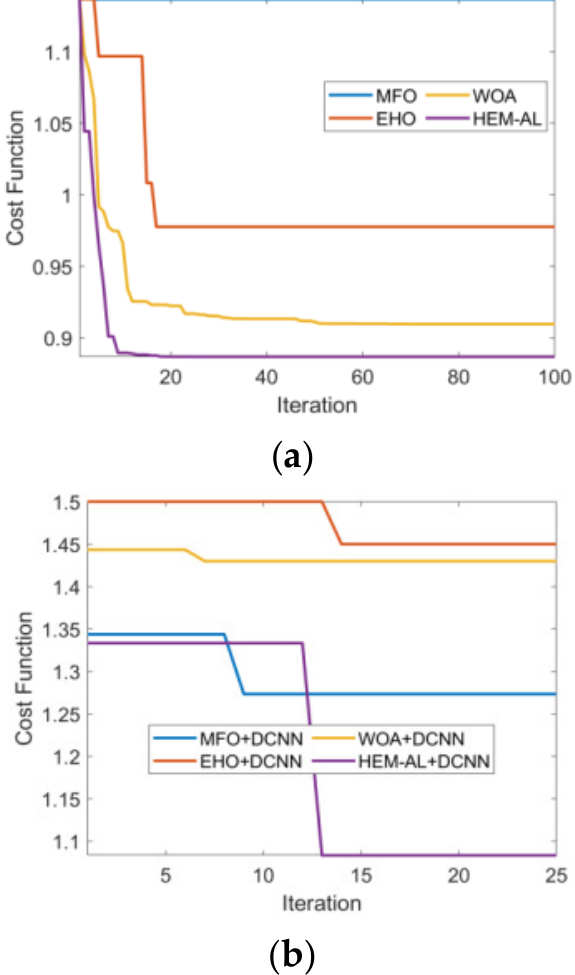
Figure 7. Convergence analysis of the developed scheme over traditional schemes in terms of cost ( a ) for optimal cluster head selection ( b ) DCNN weight optimization.